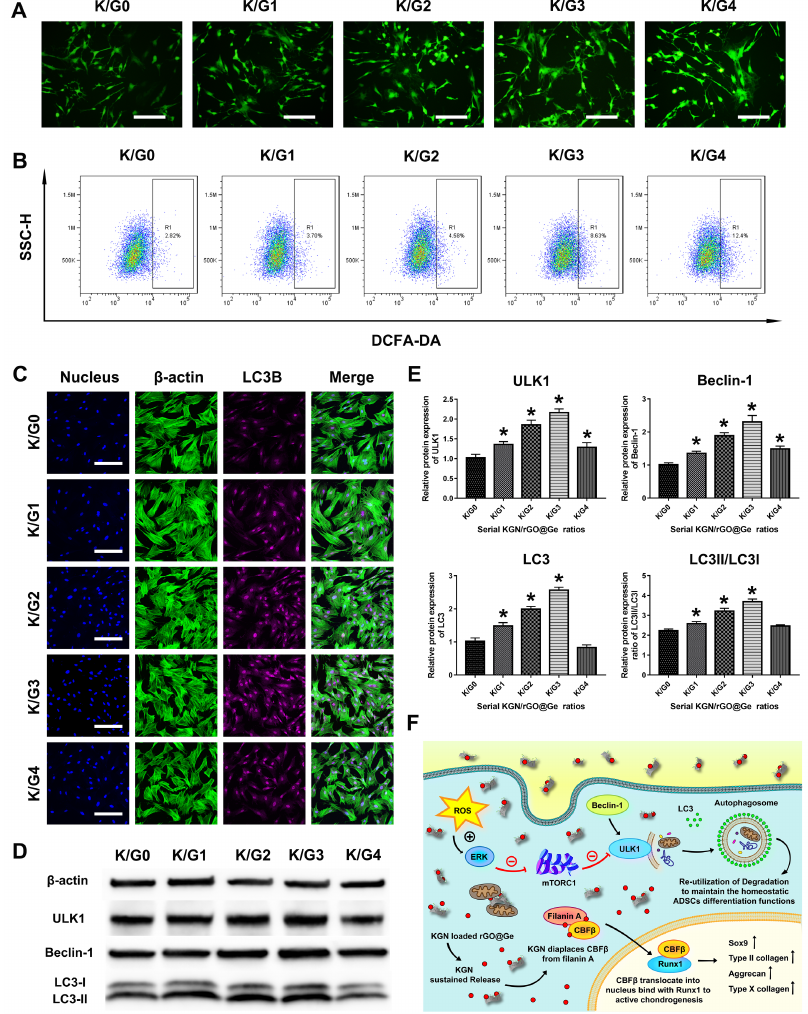
Figure 7. The change of the autophagy activity in ADSCs cultured with KGN/rGO@Ge medium. ( A ) The fluorescent microscope images of the intracellular Reactive Oxygen Species (ROS) in the different K/Gs media treated ADSCs, bar: 200 µ m. ( B ) The flow cytometry analysis on the intracellular ROS in the ADSCs treated with the different K/Gs media. R1 gated the quantitative changes of the intracellular ROS in the different groups. ( C ) The LC3B immunofluorescent staining was used to test the autophagic activities, bar: 200 µ m. ( D ) The Western blot analysis on the autophagic proteins to reflect the autophagy level in ADSCs. The ULK1, Beclin-1, and LC3 were all expressed most in the K/G3 group. ( E ) The quantitative analysis of the ULK1, Beclin-1, LC3, and LC3II/LC3I. * p < 0.05 indicates a significant difference compared to the K/G0 group. ( F ) The illustration of the mechanism that KGN/rGO@Ge induced the ADSCs chondrogenic differentiation as the nanocarrier for delivering KGN and regulating autophagy activity. The ROS activated the Erk1/2 signal pathway, then the mammalian target of rapamycin complex 1 (mTORC1) was inhibited and the mammalian target of rapamycin (mTOR) within mTORC1 was also inhibited, so the complex of mTOR and ULK1 would disassemble and the dissociated ULK1 from mTOR further initiated the